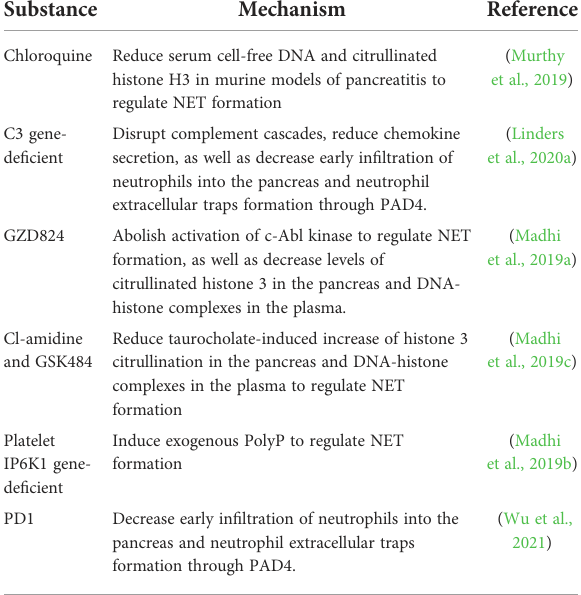
TABLE 3 Intervention in NETs, and their mechanisms in AP therapy.